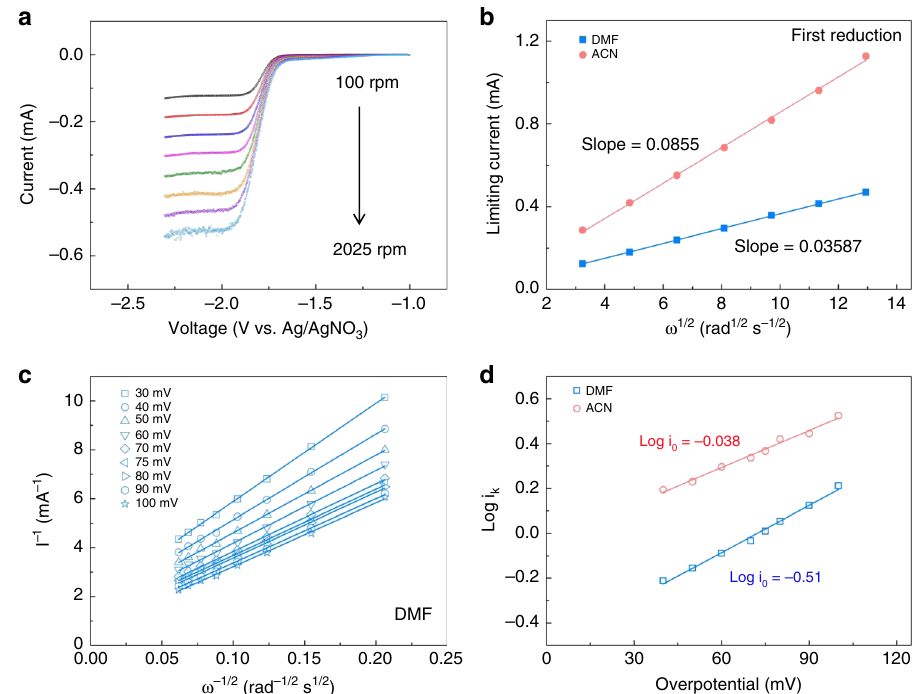
Fig. 2 Electrochemical property of AB electrolytes. a LSV scans of 10 mM AB in DMF solvents with 0.5 M TEABF 4 . b Linearly fi tted Levich plots of AB for the fi rst reduction in DMF and ACN supporting electrolytes, respectively. c Koutecky – Levich plots of AB in 0.5 M TEABF 4 DMF supporting electrolytes. d Linearly fi tted plots based on Butler – Volmer equation as a function of